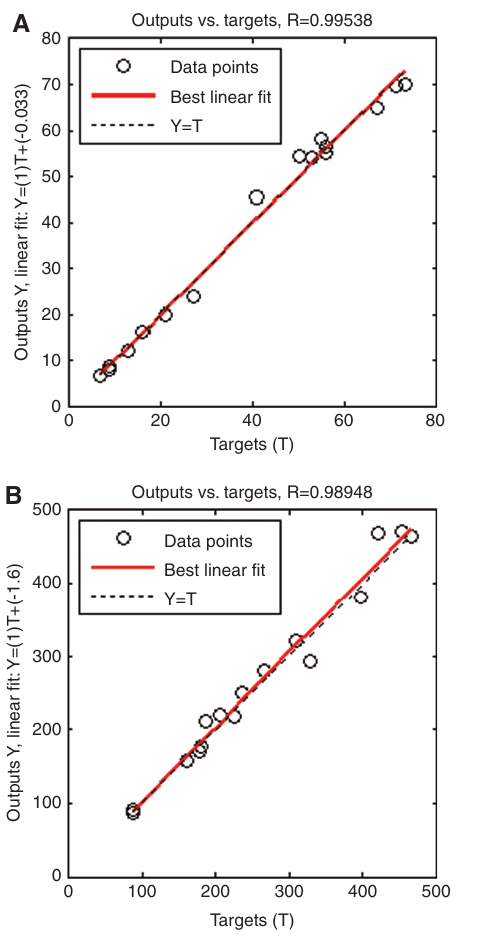
Figure 8 Relationship between experimental and ANN predicted values for the testing data set: (A) particle size ( μ m), (B) particle hardness